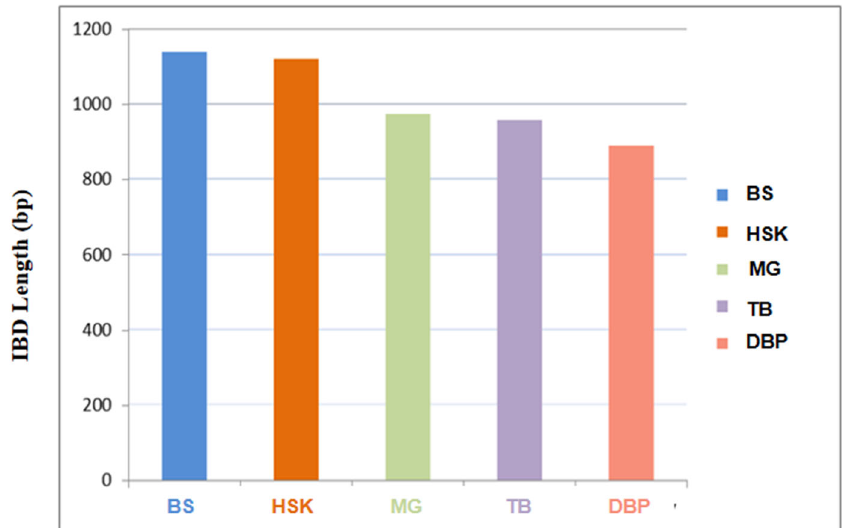
Figure 4. The estimation of identity by descent shared between the Chakouyi horse and other CHBs. HSK, Kazak horse; MG, Mongolian horse; TB, Tibetan horse; BS, Baise horse; DBP, Debao pony.